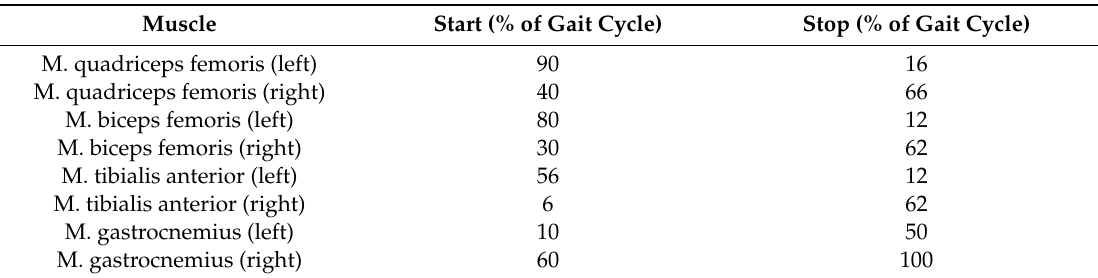
Table 1. Timing of stimulation, adapted from [25]